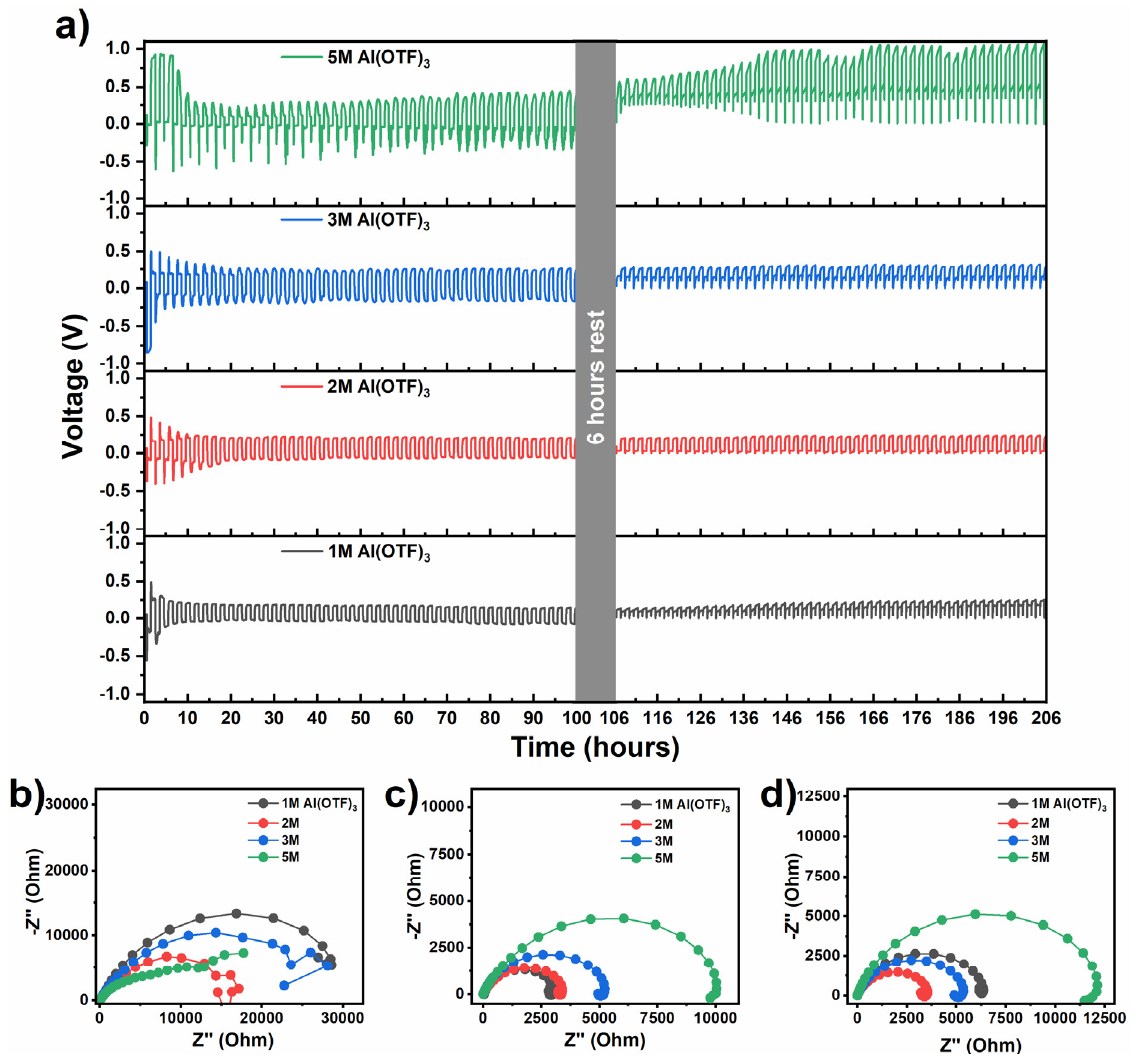
Figure 1. ( a ) Long − term stability of the electrolyte under a cyclic load of 0.01 mA cm − 2 ; ( b ) electrochemical impedance spectroscopy (EIS) of the electrolyte before cycling; ( c ) EIS of the electrolyte after 100 h of charge − discharge cycles; ( d ) EIS of the electrolyte after 200 h of charge–discharge cycles.